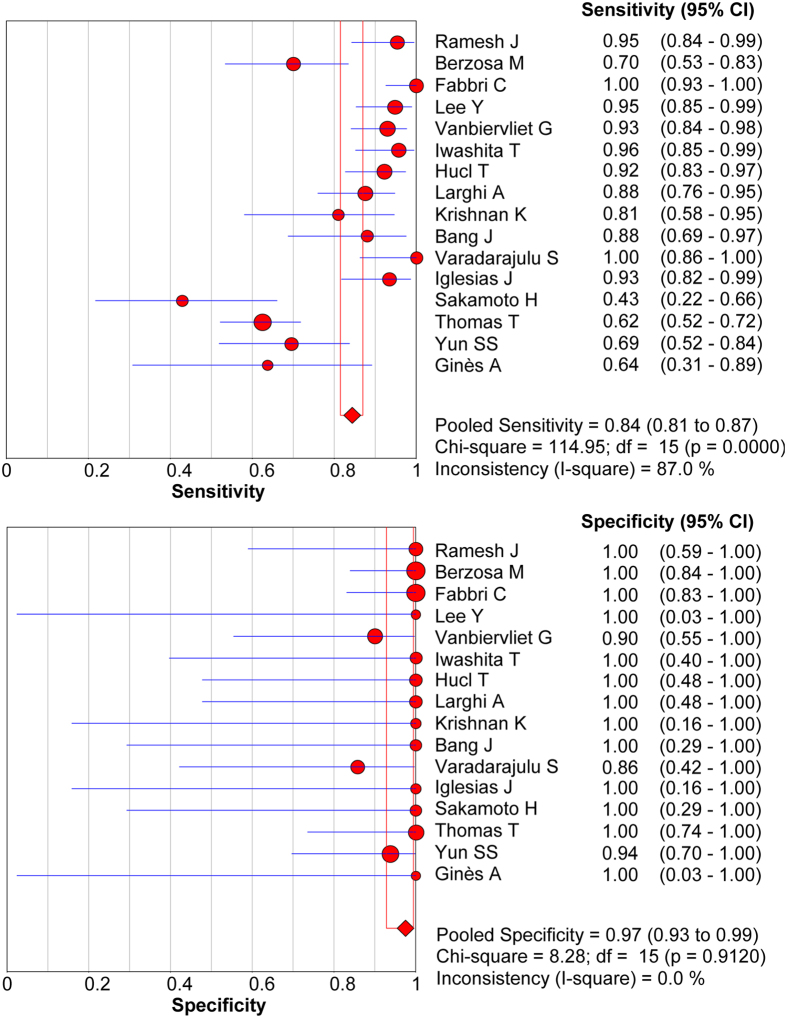
Forest plot of sensitivity and specificity estimates for EUS-FNB in the diagnosis of malignant pancreatic lesions.The point estimates of sensitivity and specificity from each study are shown as solid circles. Error bars indicate 95% CIs. EUS-FNB, endoscopic ultrasound-guided fine needle core biopsy; CI, confidence interval.